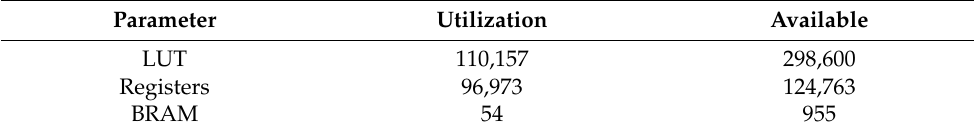
Figure 13. Actual test environment. Table 6. The consumption of the main resources of the algorithm in the FPGA.